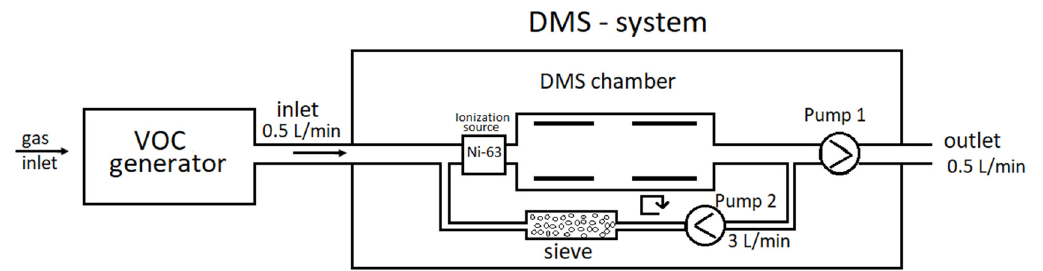
Figure 3. Diagram of the measurement system.